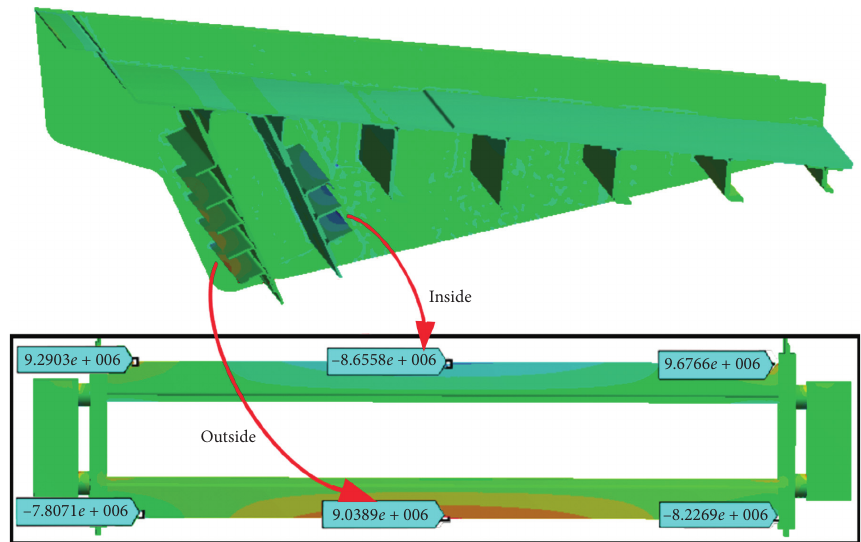
Figure 10: First principal stress cloud diagram of vibrating feeder with exciting force